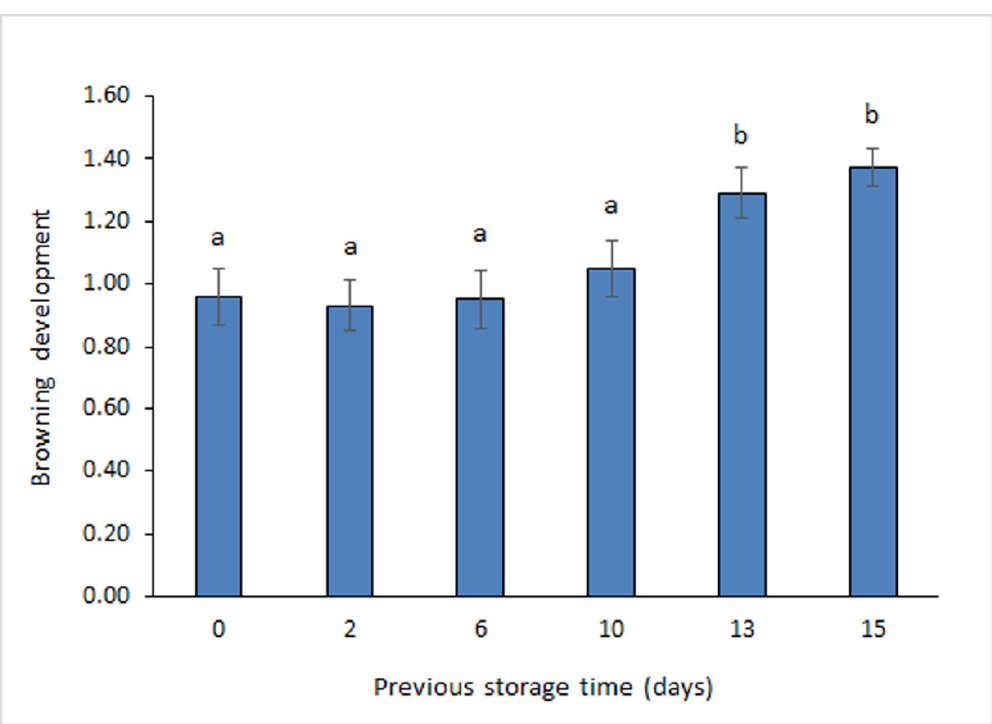
Figure 3. Determination of the browning development in canned sardines muscle subjected previously to storage on ice. Average values of three replicates ( n = 3). Standard deviations are indicated by bars. Average values accompanied by different letters (a,b) denote significant differences ( p < 0.05).